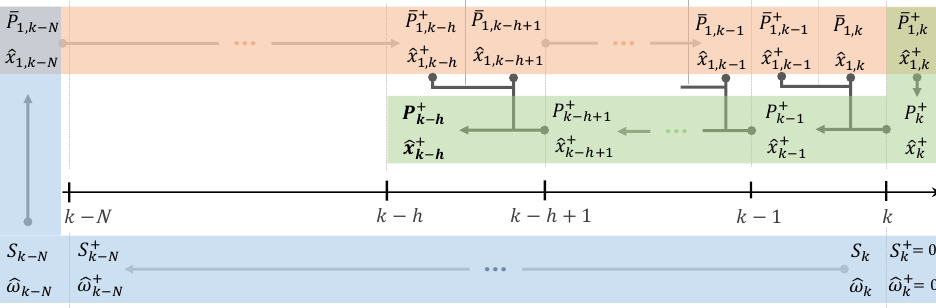
Figure 2. Concept of the RHRTSF